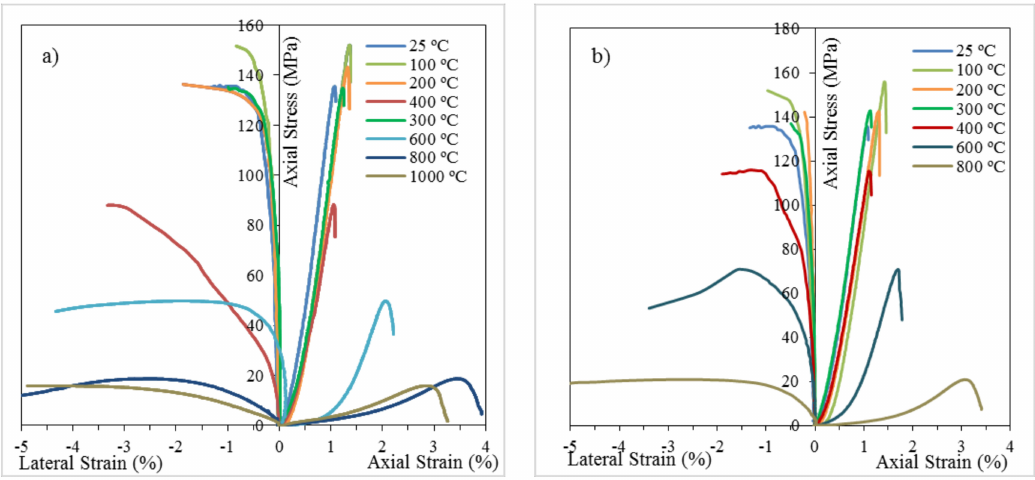
Figure 7. Stress-strain curves during loading for heat-treated specimens ( a ) for rapidly cooled specimens ( b ) for slowly cooled